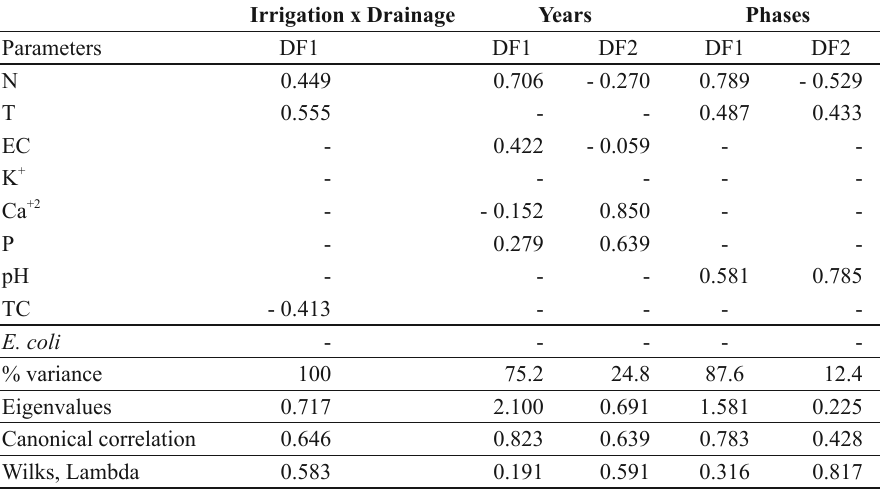
Matrix standardized coef fi cient, percentage of variance, eigenvalues, canonical correlation, and Wilks lambda for discriminant analysis variation in quality of irrigation and drainage water in Camaquã/RS/Brazil.